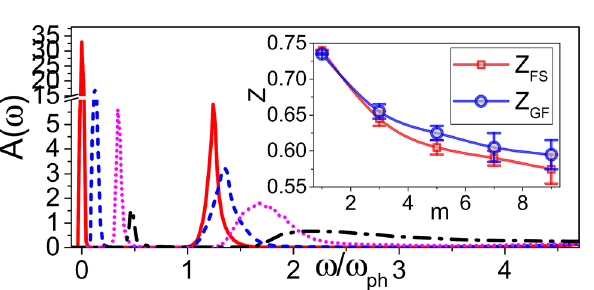
4 from m 3.8 10 16 simulations: q ( 0, 0 ) − = × = = ( 2 π/ 8, 0 ) (magenta dotted line), and q ( 3 π/ 8, 0 ) (black = = 0 . Inset: Order-by-order = 0 : (i) using =